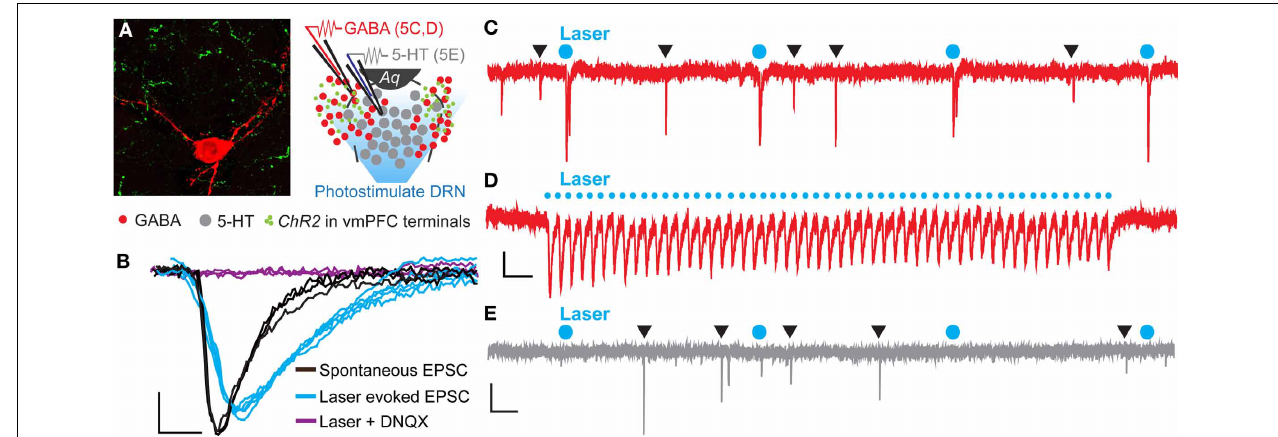
FIGURE 5 | Photoactivation of vmPFC terminals results in time-locked EPSC events in DRN GABA neurons. (A) High magnification confocal image of a biocytin-filled recorded GAD2-tdTomato neuron (red) in close contact with axon terminals from vmPFC neurons (green) anterogradely traced using AAV- CaMKIIa - ChR2-YFP . Inset displays a schematic of DRN topography in recorded slices from GAD2-tdTomato mice. Recorded neurons were purposely selected in ventrolateral subregions of the DRN that are rich in afferents from the vmPFC while the DRN was photostimulated. Aq —aqueduct. (B) Average voltage-clamp traces of